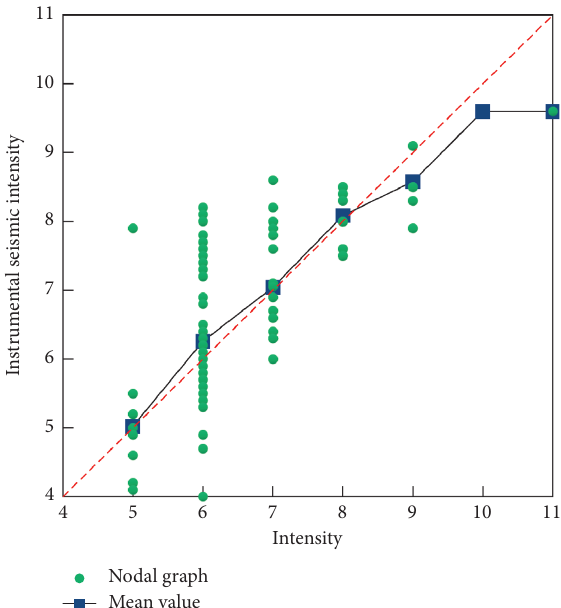
Figure 1: Comparison of seismic intensity and instrumental seismic intensity at strong motion observation